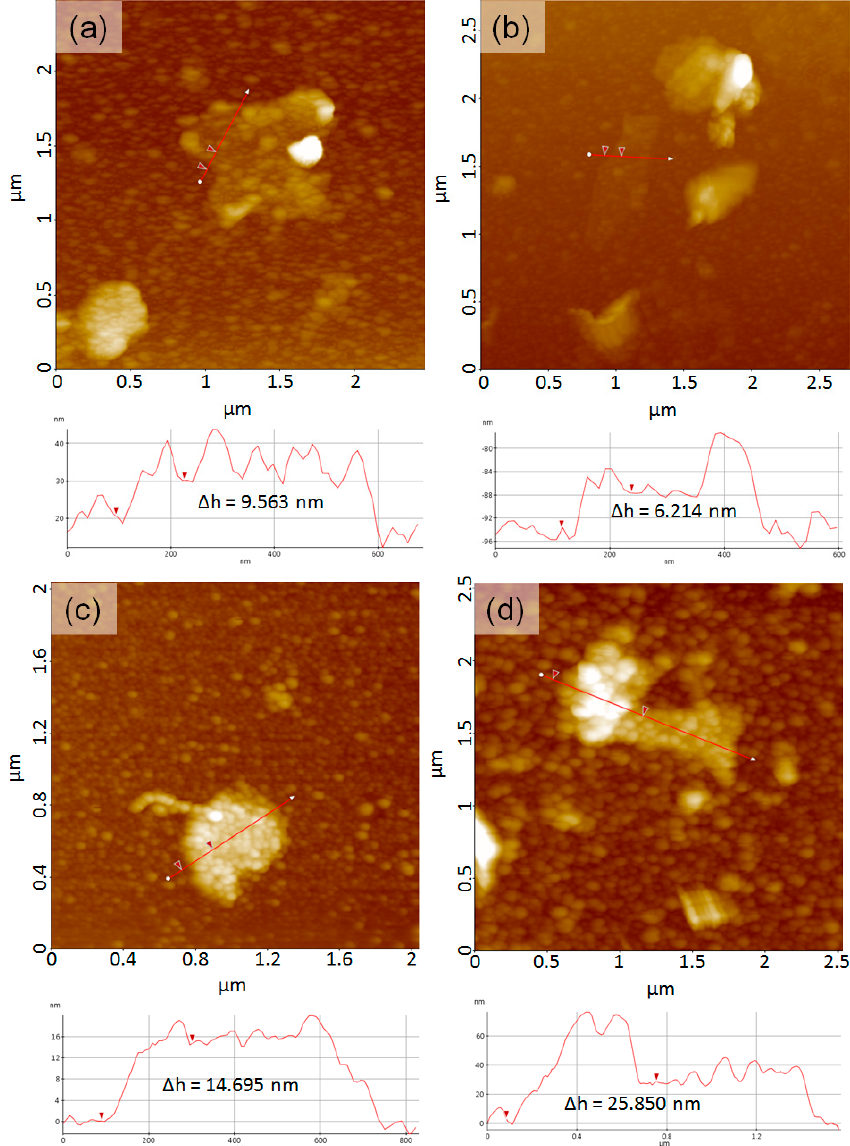
Figure 8. Atomic Force Microscopy (AFM) topographic images of the supernatant solution from HOPG dispersions with ( a ) PTFEMA 66 - b -PVP 41 , ( b ) PTFEMA 66 - b -PVP 205 , ( c ) PTFEMA 136 - b -PVP 31 , and ( d ) PTFEMA 136 - b -PVP 194 . Height profiles from the red line on topographic images are depicted below their corresponding images ( a – d ), and the Δ h in height profile reveals the height diffrences between red triangles.